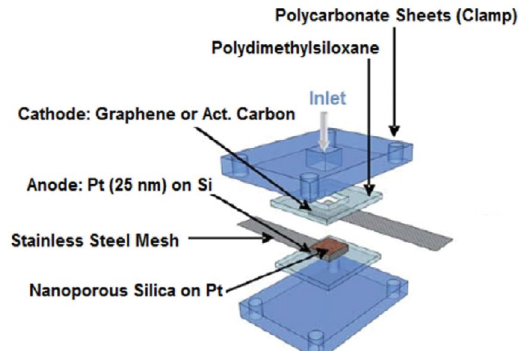
Fig. 6. Schematic for abiotic glucose fuel cells using mesoporous silica as the membrane